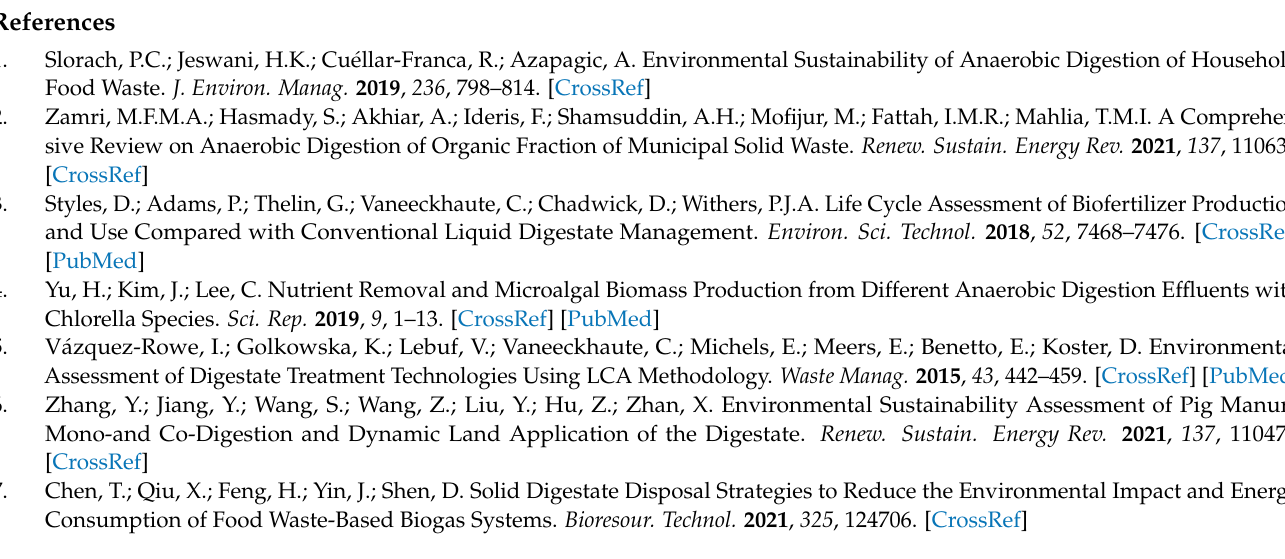
Figure A1. Optical density of P. kessleri culture in 550 nm wavelength versus dry weight of biomass.